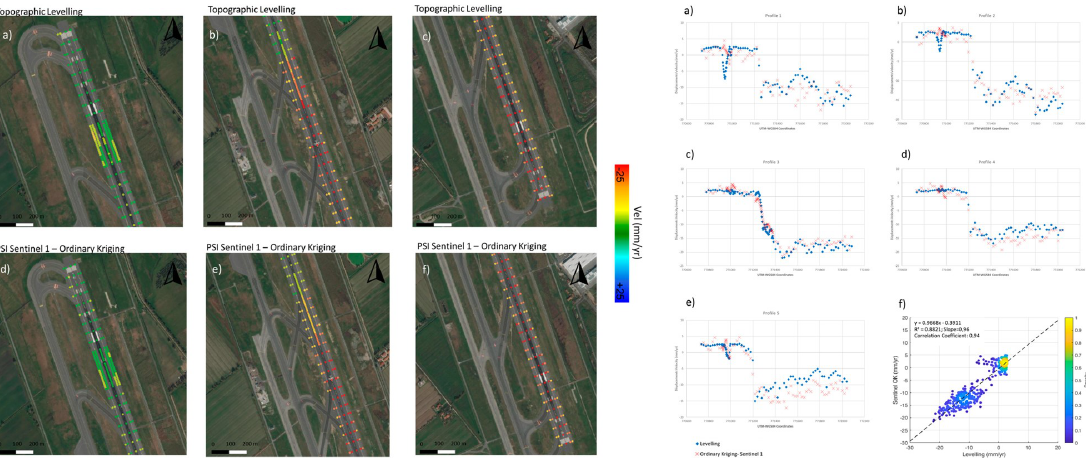
Figure 13. Integrated monitoring of runways through Sentinel-1 SAR products processed by MT- InSAR and interpolated by geostatistical methods and levelling, modified from [108]. Displacement velocity trends of the Sentinel-1 PSI data interpolated by a Kriging geostatistical approach (red cross markers) and longitudinal survey profiles ( a – e ) by topographic levelling (blue squared markers); ( f ) scatter plot of the interpolated Sentinel-1 and levelling deformations, with regression line.